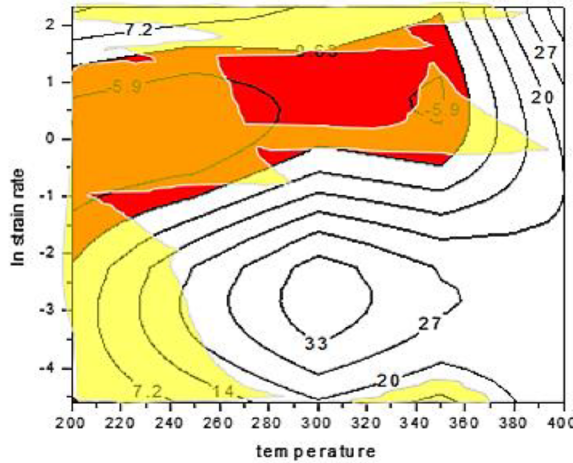
Figure 7: Processing maps of Al 6063/6 wt.% steel p composite at strain of